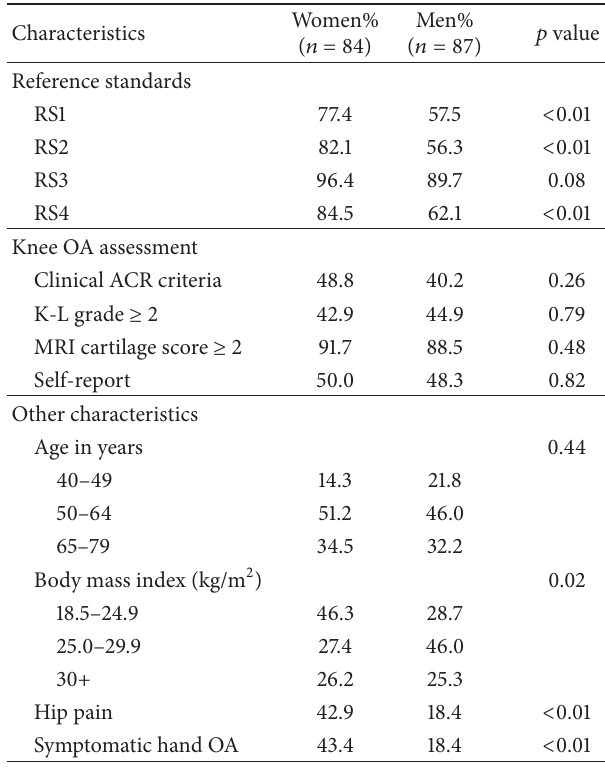
Table 1: Percentage of knee, hand, and hip osteoarthritis (OA) by each reference standard, knee OA assessment, and other baseline characteristics of 171 subjects who underwent comprehensive clin- ical assessment for knee OA by